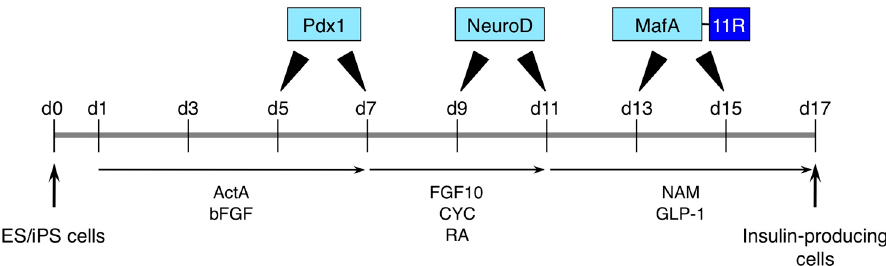
Figure 3. Scheme of the protocol for pancreatic differentiation with Pdx1, NeuroD and MafA-11R protein transduction. Dissociated mouse ES or iPS cells were plated at day 0 and directed to pancreatic differentiation in medium supplemented with Activin A (ActA) and basic fibroblast growth factor (bFGF) from days 1 to 7, followed by medium supplemented with fibroblast growth factor 10 (FGF10), KAAD-cyclopamine (CYC), and retinoic acid (RA) from day 7 to 11, and medium supplemented with nicotinamide (NAM) and glucagon-like peptide-1 (GLP-1) from day 11 to 17. At day 17, a part of differentiated cells express insulin and mature pancreatic β -cell markers. Blue boxes show recombinant proteins of Pdx1, NeuroD, and MafA-11R and these proteins were added at the indicated time-points. d: day; 11R: 11 arginine.